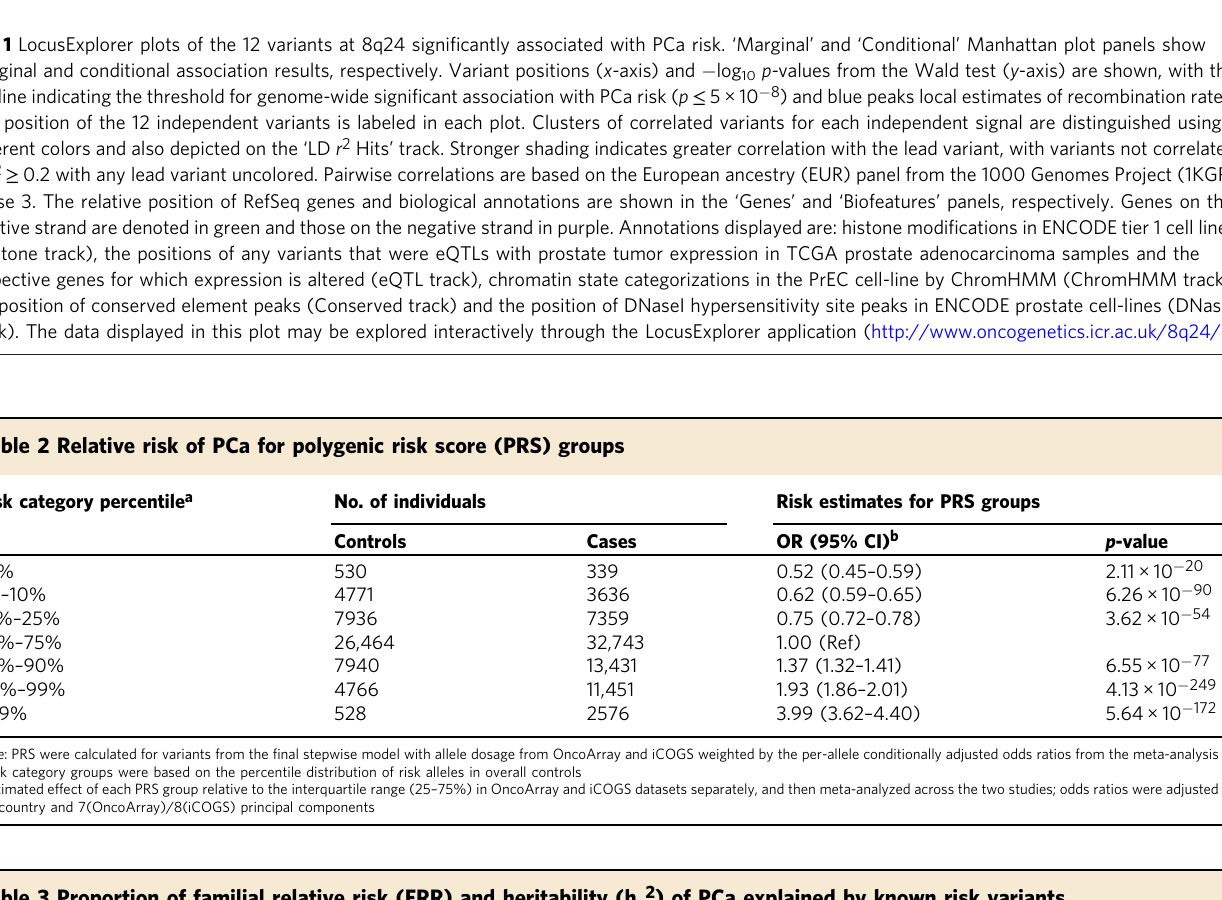
Table 3 Proportion of familial relative risk (FRR) and heritability (h g 2 ) of PCa explained by known risk variants